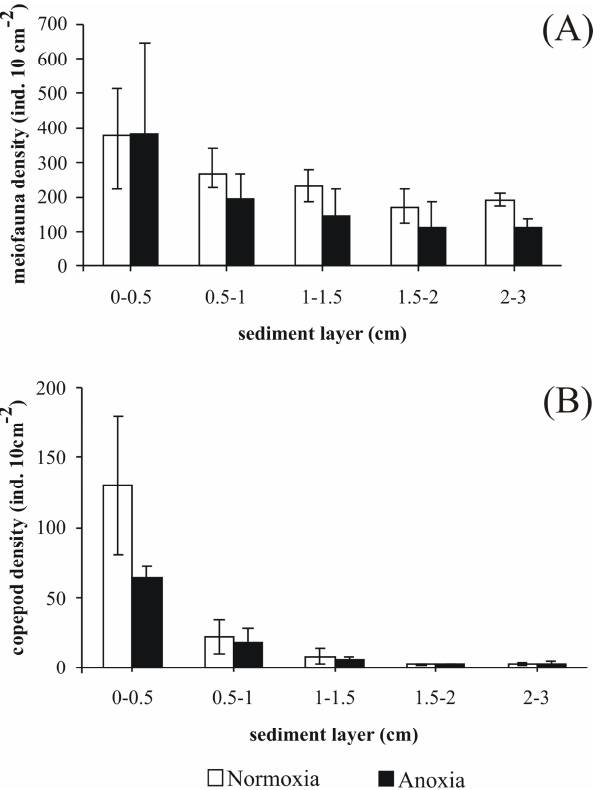
Figure 3. Average (± STDEV) total densities of (A) meiofauna and (B) copepods in normoxic 2 Fig. 3. Average ( ± stdev) total densities of (A) meiofauna and (B) and anoxic field conditions. 3 copepods in normoxic and anoxic field conditions.